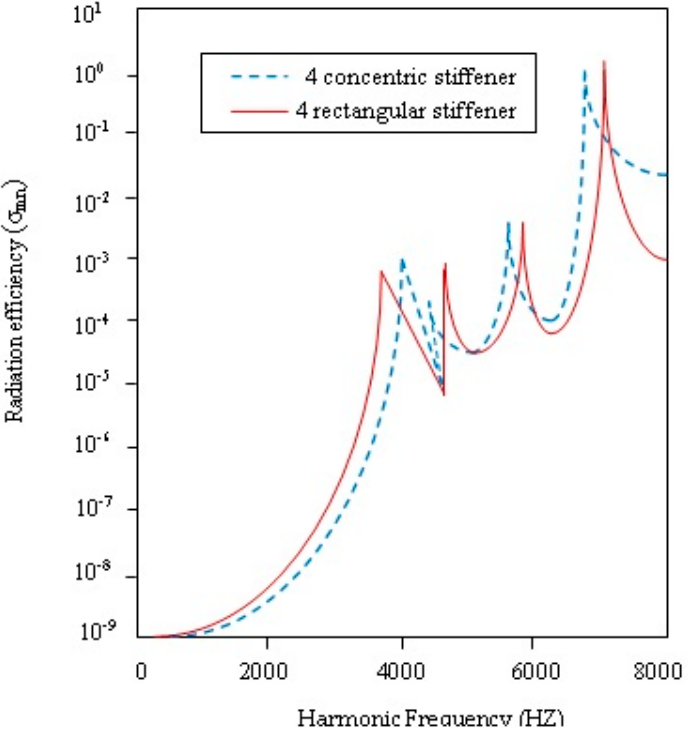
Figure 26. Numerical comparison of radiation efficiency ( σ mn ) for annular plate attached with 4 rectangular and 4 concentric stiffener patches and having parabolic decreasing thickness variations (Case I) for taper ratio T x = 0.75.